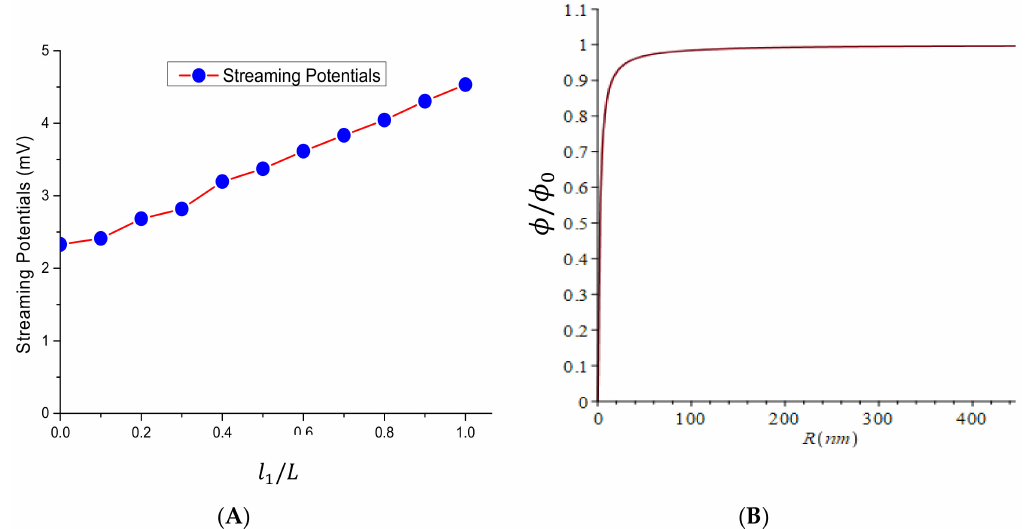
Figure 6. ( A ) Streaming potentials versus the ratio of l 1 / L. ( B ) Normalized streaming potentials versus the radius of a capillaryBecause the microcanals in bone are curved and branched, the distribution of the electric charges on the inner surface of the microcanals or solid surfaces are not uniform, which can be explained by the mechanism of Maxwell–Wagner polarization in bone. Maxwell–Wagner polarization (MWp), also known as interfacial polarization or space charge polarization, occurs in a porous composite dielectric composed of segregated constituents with di ff erent dielectric permittivity and electrical conductivity